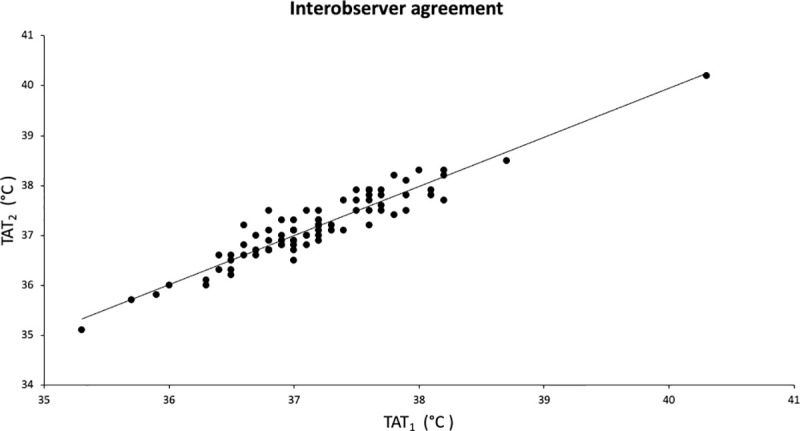
Scatterplot interobserver agreement.Scatter plot for body temperature data. Correlation between body temperature data obtained by observer 1 (TAT1) and observer 2 (TAT2) is illustrated.